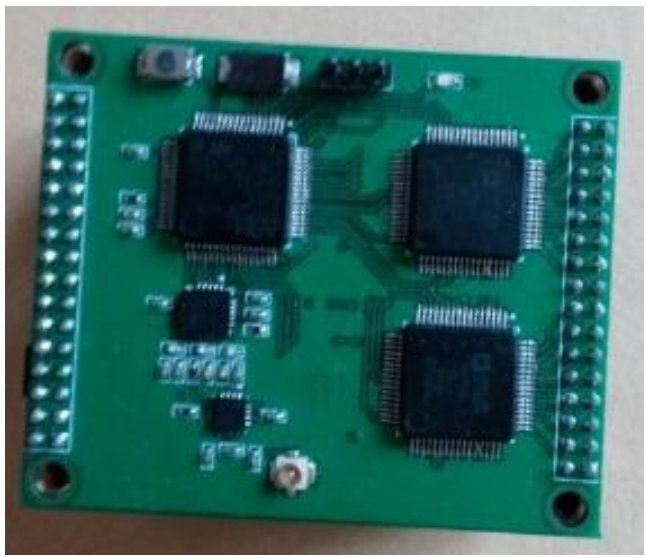
Figure 4. Wireless wind pressure test system developed in the present study.